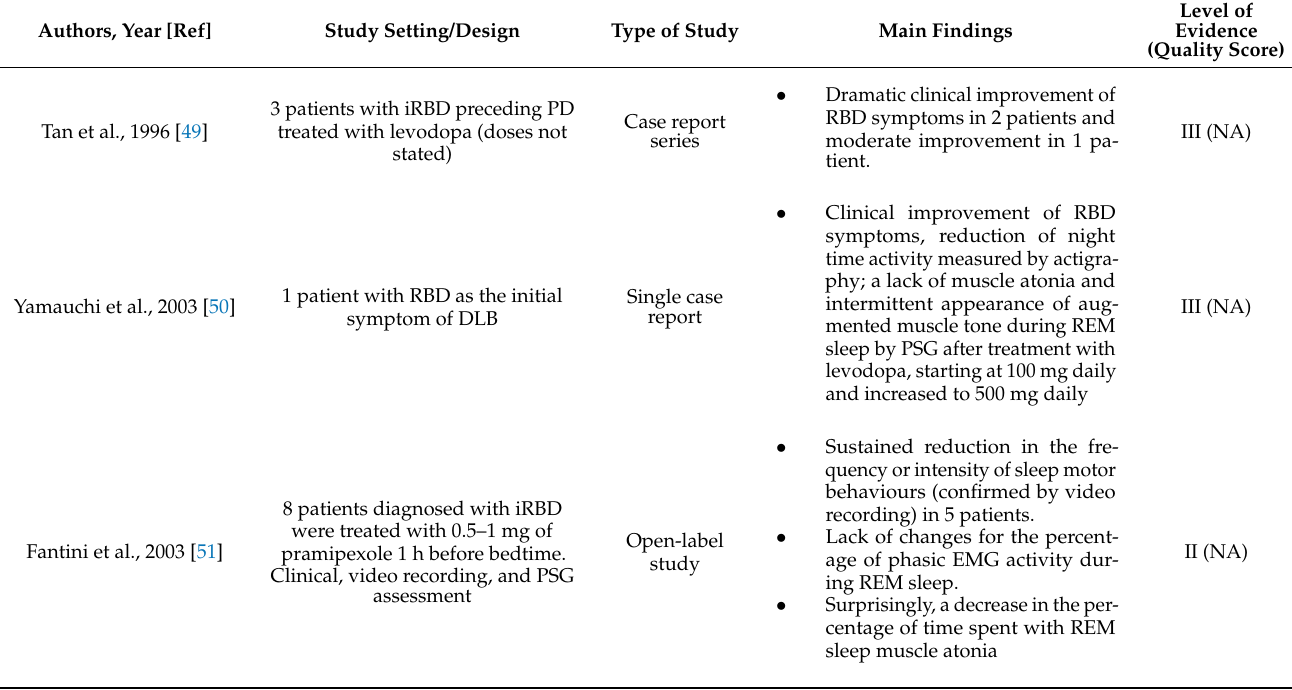
Table 4. Studies describing effects of levodopa and dopamine agonists in patients with